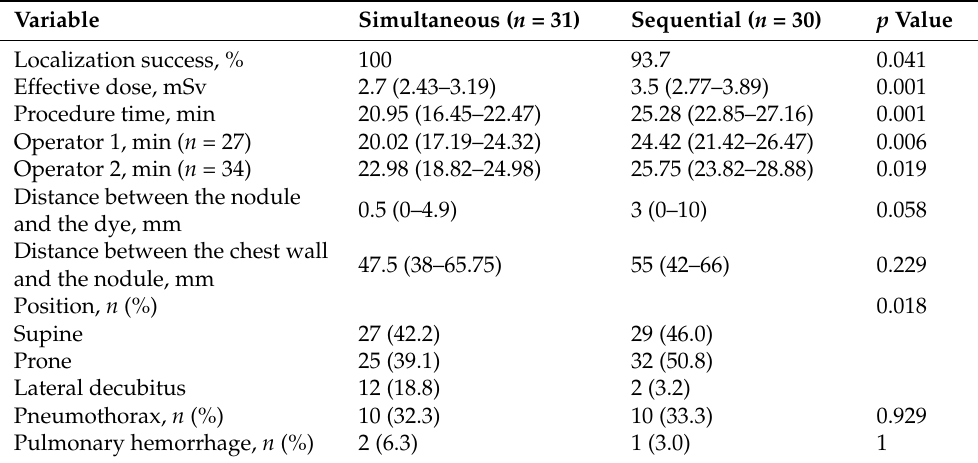
Figure 2. Simultaneous puncture with PBD injection of three nodules in a 70-year-old male. ( A – C ) Axial CT scan showed 22-gauge Chiba needles simultaneously puncturing two subsolid nodules (arrow) in the RUL and one subsolid nodule (arrow) in the RML during one breath-hold; ( D ) VATS identified PBD stains ( (cid:70) ) of the three nodules on the visceral pleura of the RUL and RML. All pathological results indicated invasive adenocarcinoma. Abbreviations: RUL, right upper lobe; RML, right middle lobe. Table 2. Preoperative results and complications of CT-guided